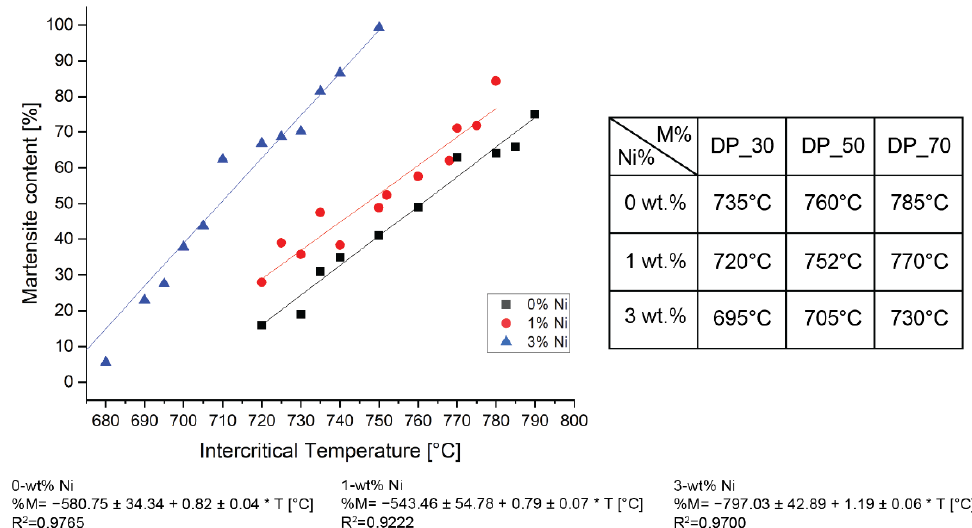
Figure 3. Martensite content from samples heat-treated for 30 min at varying intercritical temperatures. Analysis of martensite composition was performed by point counting following the ASTM E562-19 [27].